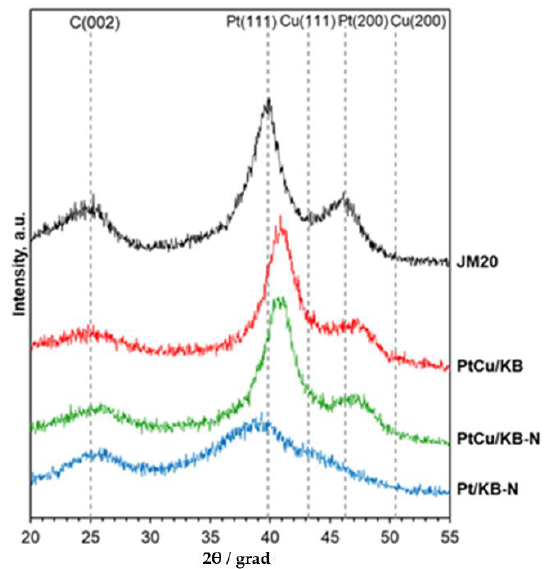
Figure 1. XRD patterns of the obtained and commercial Pt/C catalysts.